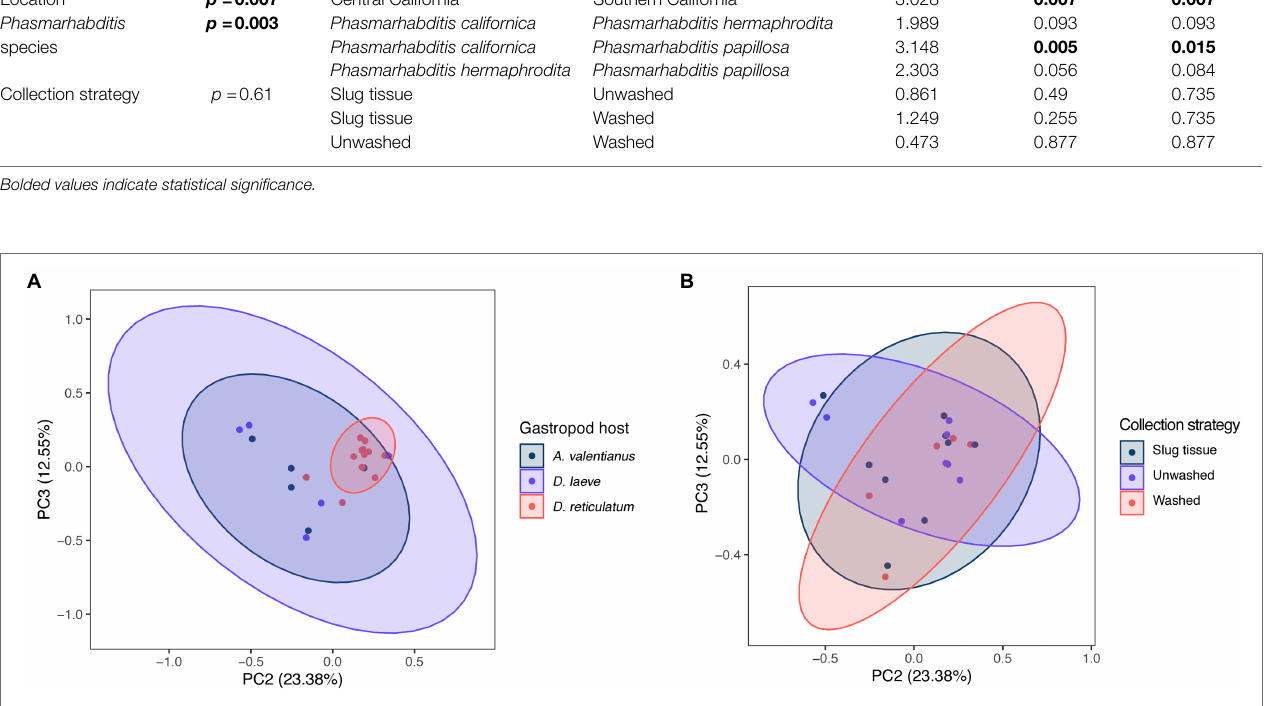
FIGURE 4 | PCoA plots of nematode microbial community of different gastropod hosts, based on Bray Curtis distance. PCoA plots with samples clustered by (A) gastropod host and (B) collection strategy; % variance explained shown in parentheses for each axis. Ellipses show 95%